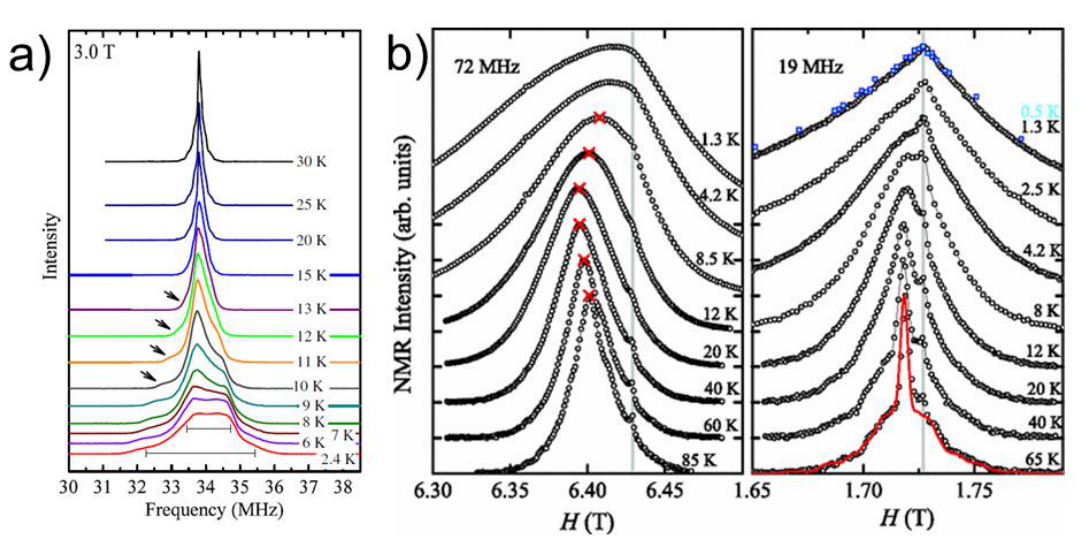
Figure 5. The 51 V NMR spectra of vesignieite, BaCu 3 V 2 O 8 (O) 2 . ( a ) Fixed magnetic field B = 3.0T with varying temperature. Reproduced with permission from [132]. © 2013 The Physical Society of Japan. ( b ) Spectra from 72 (left) and 19 MHz (right) normalized for visibility. Gray lines indicate the reference field, the red line is powder simulation for comparison. Red x’s determine the line shift. Figure reprinted with permission from Ref. [131]. © 2011 by the American Physical Society.